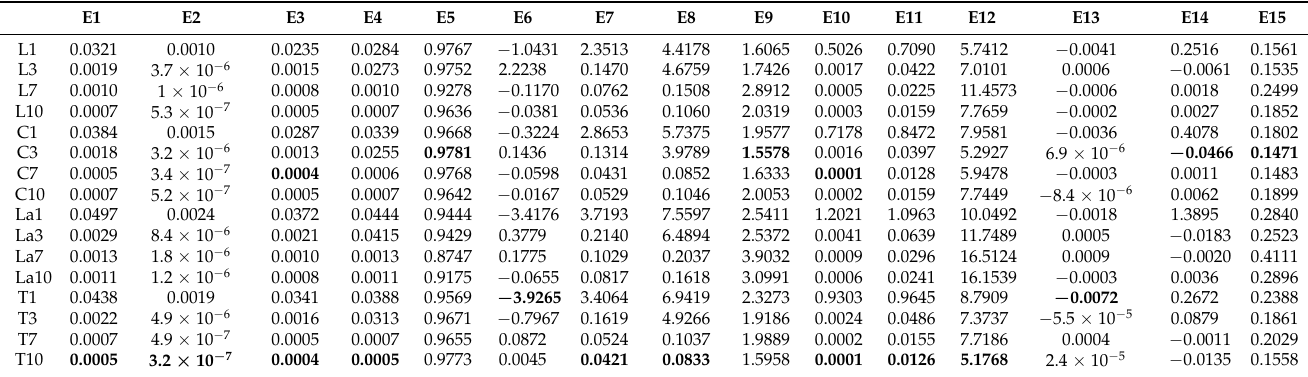
Table 14. Error values in testing 16 predictor models for Binance dataset.